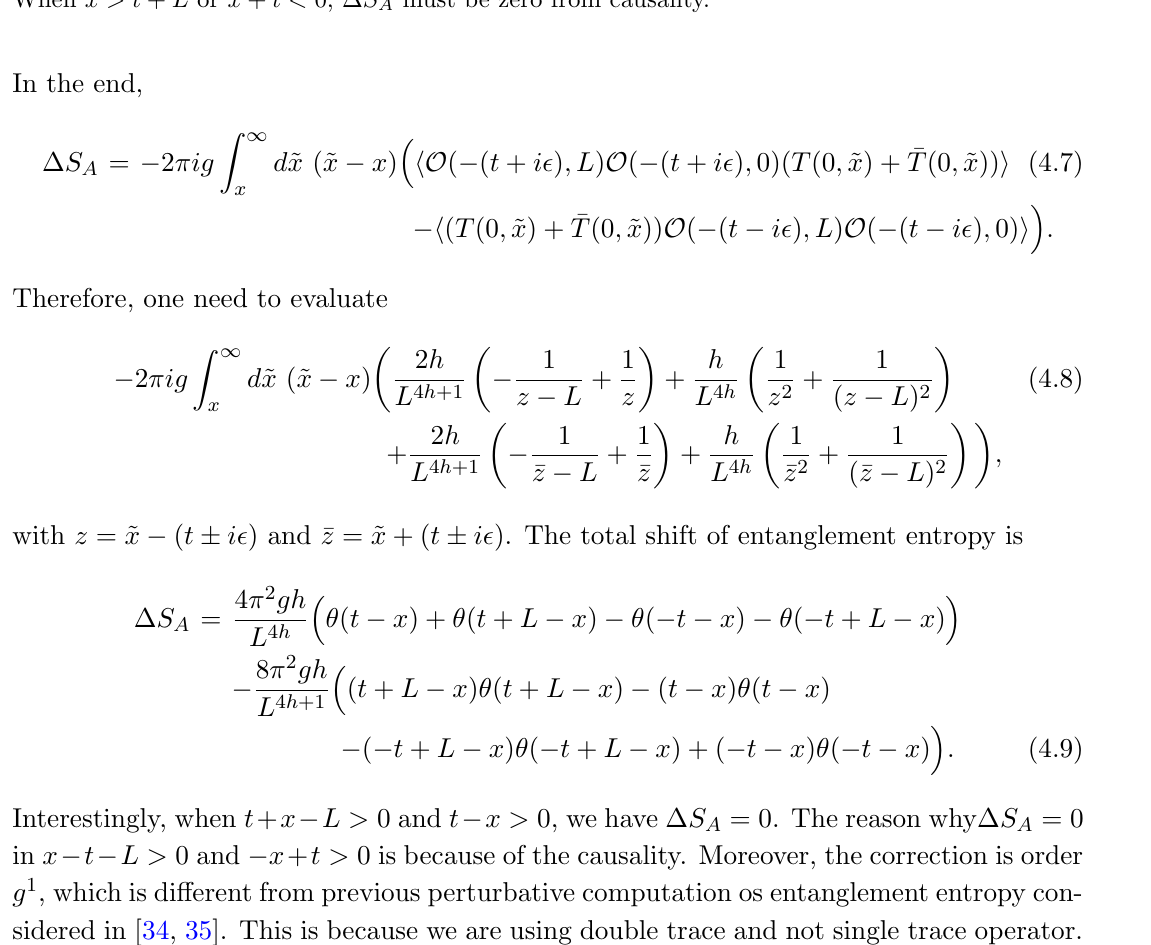
Figure 8 . Spacetime dependence of entanglement entropy (cid:1) S A after double trace deformation. When x > t + L or x + t < 0, (cid:1) S A must be zero from